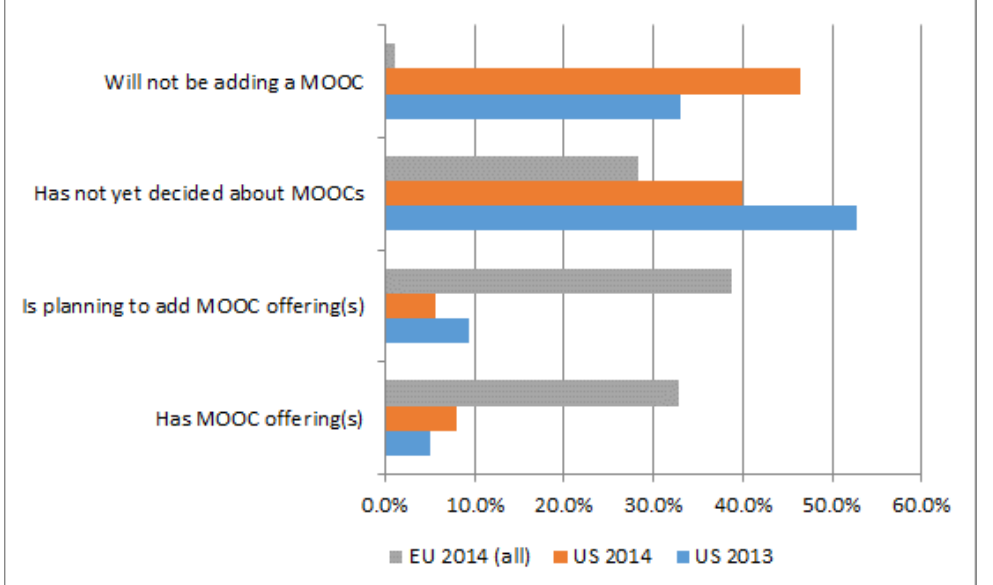
Figure 2. Institutional profile in MOOC